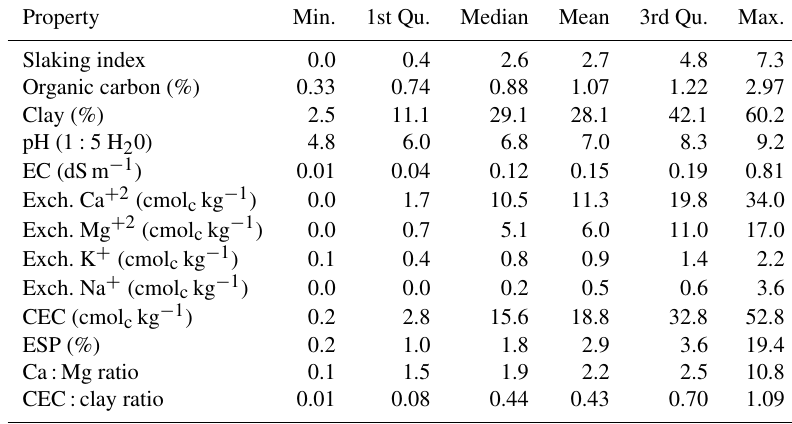
Table 3. Summary statistics of slaking index and laboratory-derived soil properties. Property Min. 1st